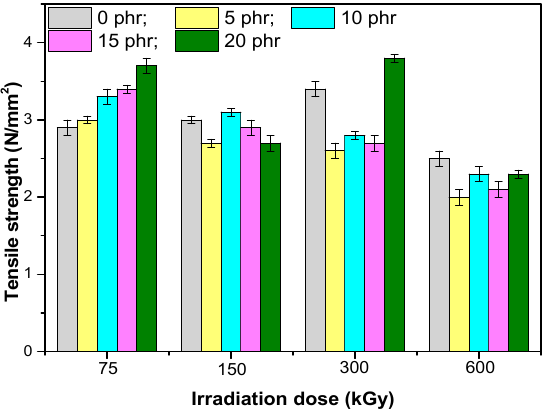
Figure 1. Tensile strength versus electron beam irradiation dose and the amount of hemp fibers.